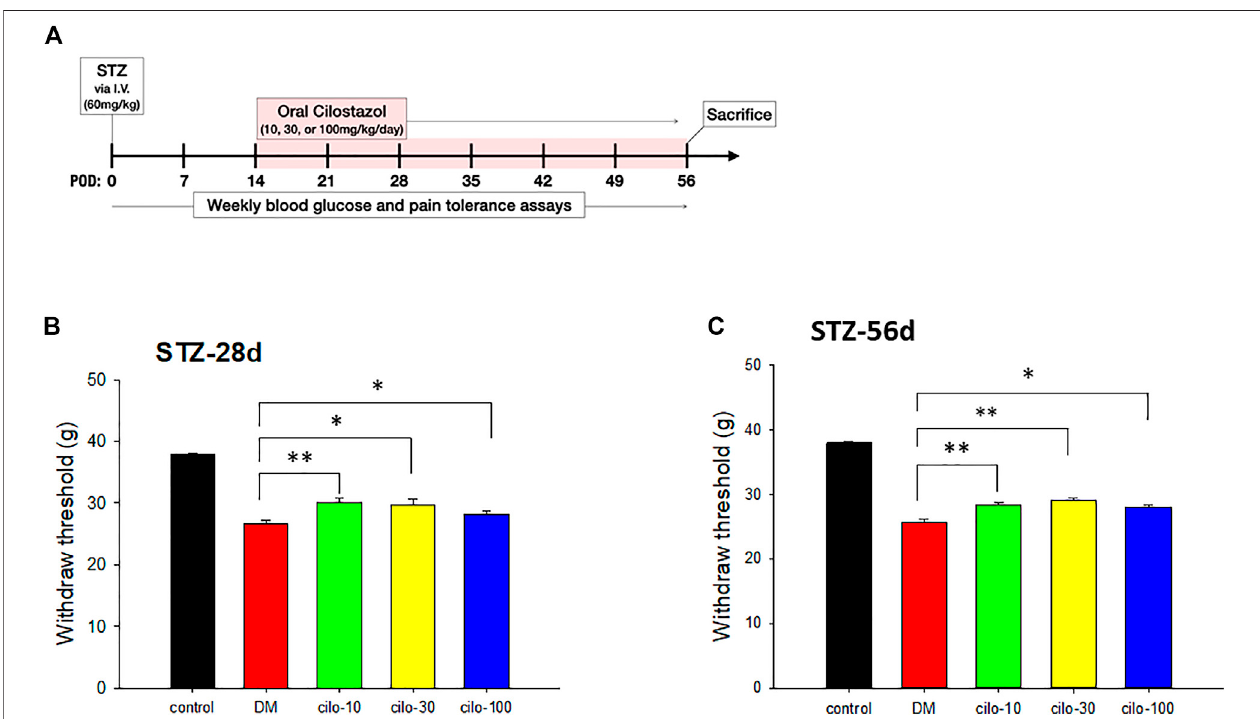
FIGURE 2 | Analgesic effect of cilostazol in streptozotocin (STZ)-induced diabetic (DM) rat model. (A) Experiment timelines outlining relative time points of intravenous (I.V.) STZ injection, commencement of daily cilostazol oral gavage, and sacri fi ce. Signi fi cant increases in tolerance against mechanical stimuli in (B) 28-days (twoweekscilostazol)and (C) 56-days(sixweekscilostazol)DMratsindicatedbyhigherlevelsofhindpawwithdrawalthresholds.POW,postoperativeweek.Resultsare expressed as mean SEM for a minimum of fi ve rats for each group. Statistical signi fi cances between the DM control and cilostazol DM treatment groups were calculated with the Mann – Whitney U test. * p < 0.05, ** p <